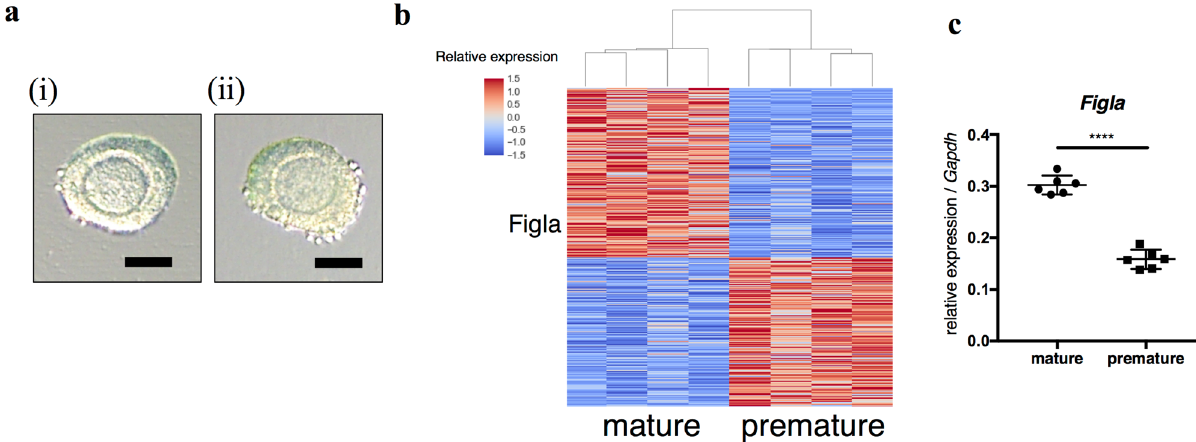
Figure 1. Differentially expressed genes in secondary follicle oocytes between mature and premature mice. ( a ) Representative pictures of the secondary follicles of (i) a mature mouse and (ii) premature mouse. Scale bars, 50 µm. ( b ) Heatmap of differentially expressed genes (DEGs, log2 fold change > 0.5, false discovery rate (FDR) < 0.01). Four samples from mature and premature mice were compared. ( c ) Expression levels of Figla in the secondary follicle oocytes of mature mice and premature mice by qRT-PCR (n = 6, in each